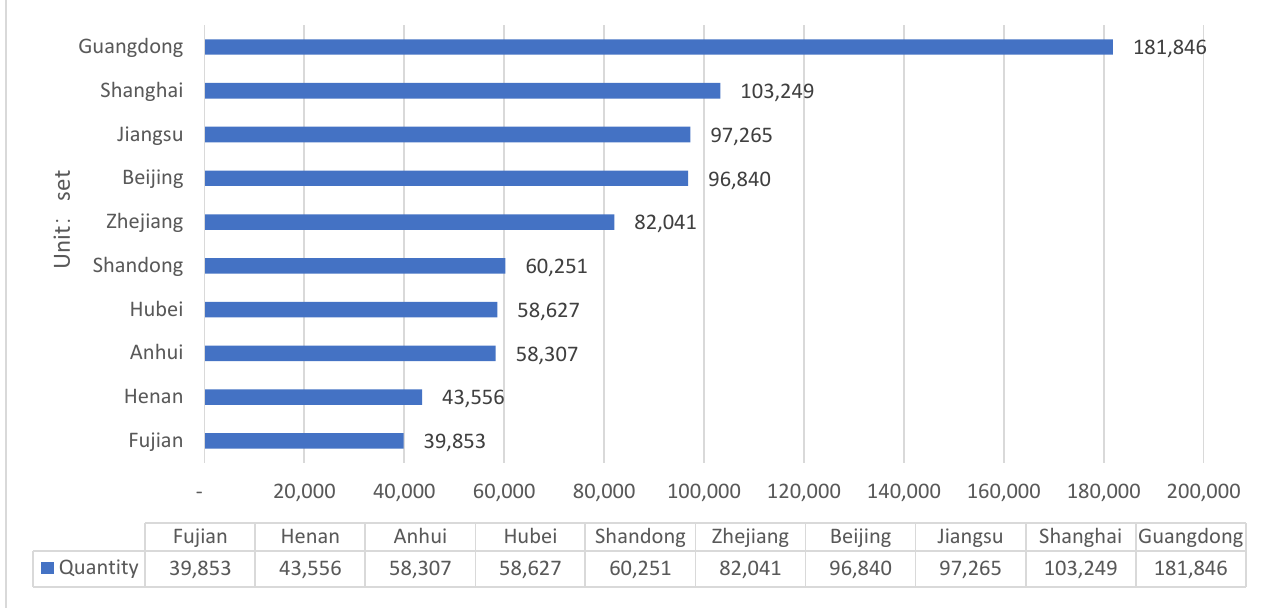
Figure 3. Ranking the public charging piles in China in 2020. Data Source: China Electric Vehicle